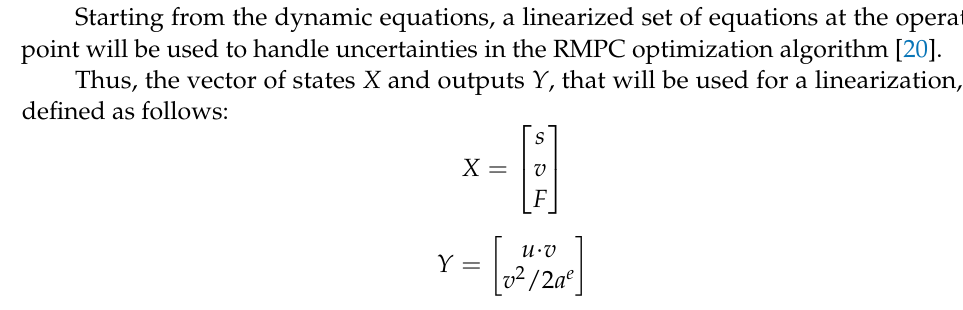
Figure 1. Slope and radius considered in the simulation scenario.